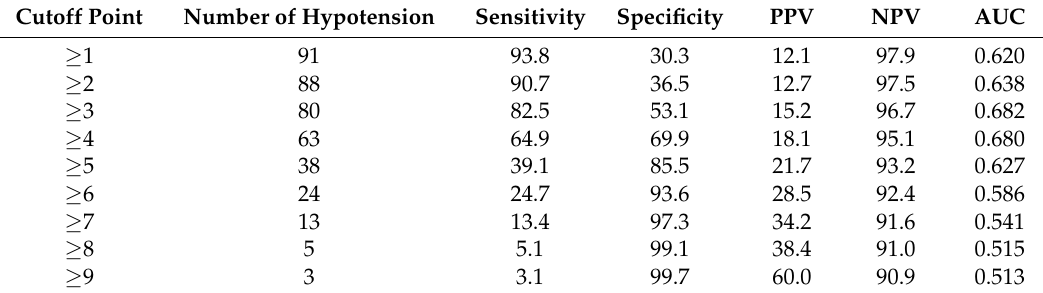
most common on endoscopic finding in the patients in the development group (Table